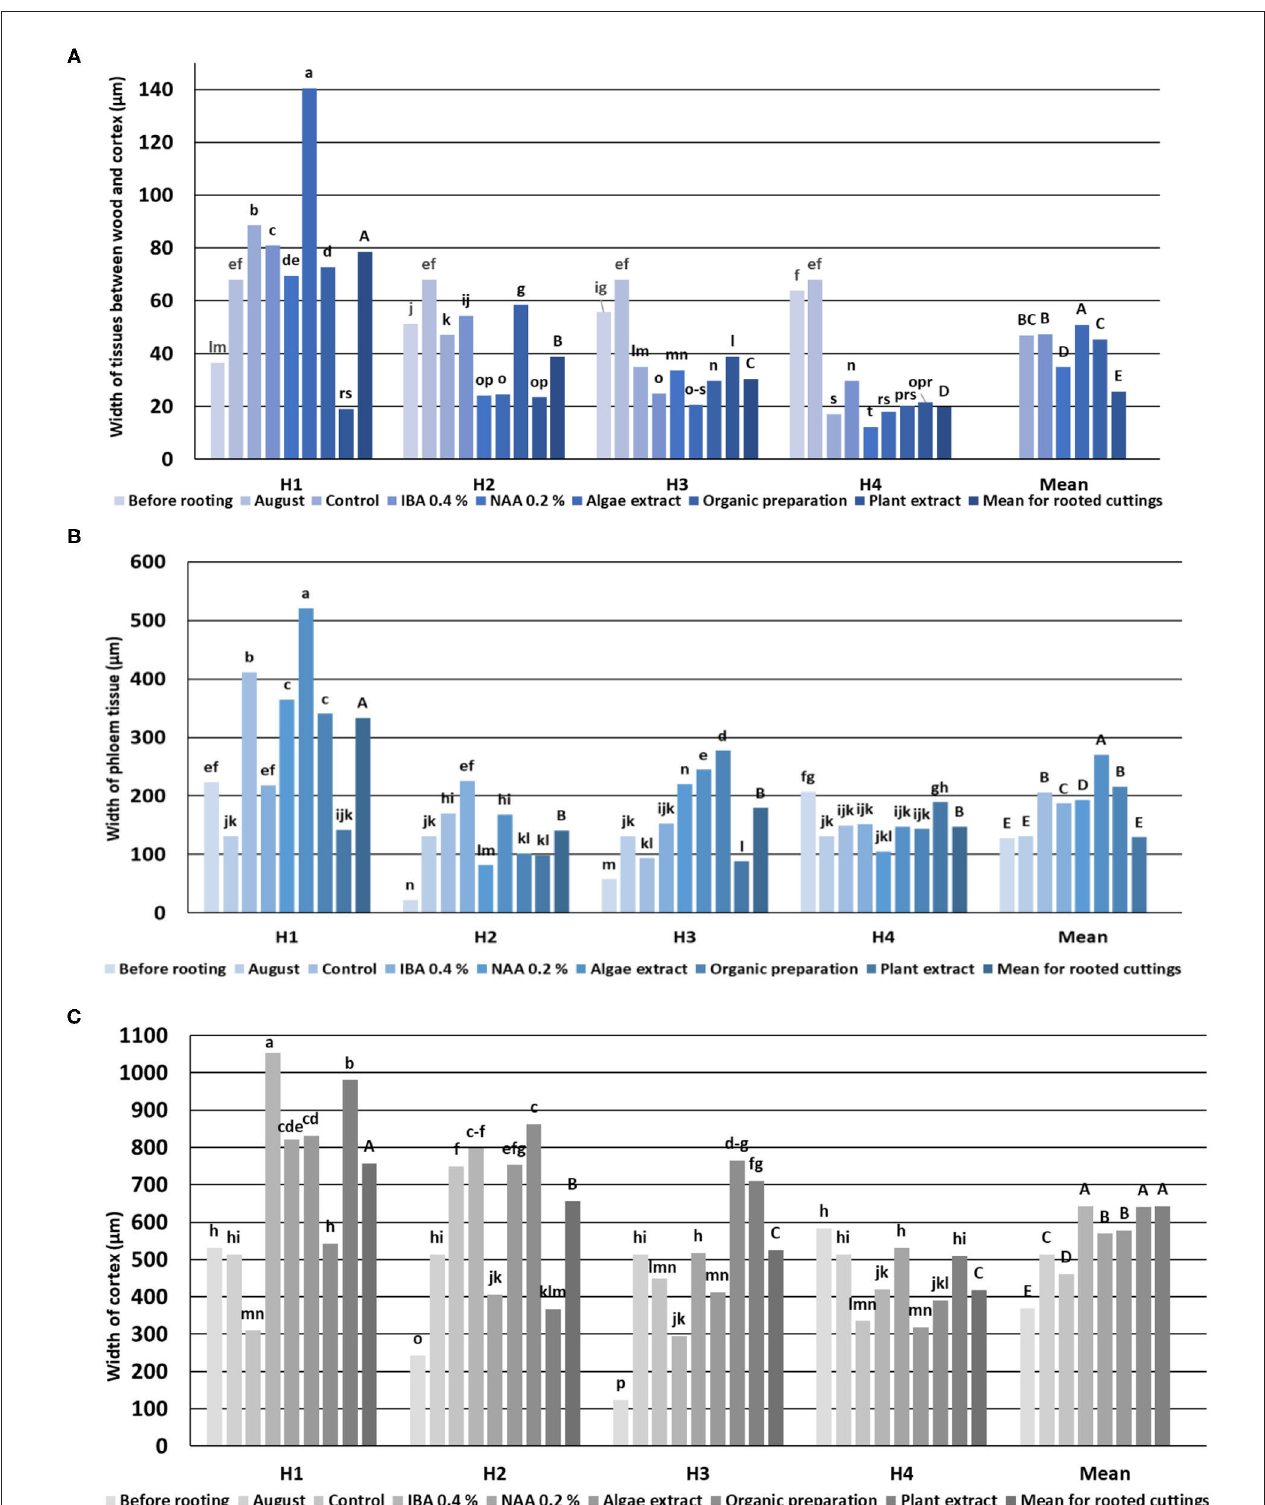
FIGURE 3 | Width of Rosa “Hurdal” tissues between wood and cortex (A) , phloem (B) , and cortex tissue (C) in stems before rooting; cuttings after 24 days of the rhizogenesis process; and stems of stock plants cut in first days of August. Control—control cuttings without rooting enhancers; IBA 0.4%—Ukorzeniacz A aqua (0.4% IBA); NAA, 0.2%—Ukorzeniacz B aqua (0.2% NAA); Algae extract—watering with 0.6% Bio Rhizotonic (10ml) after planting and 10 and 20 days later; Organic